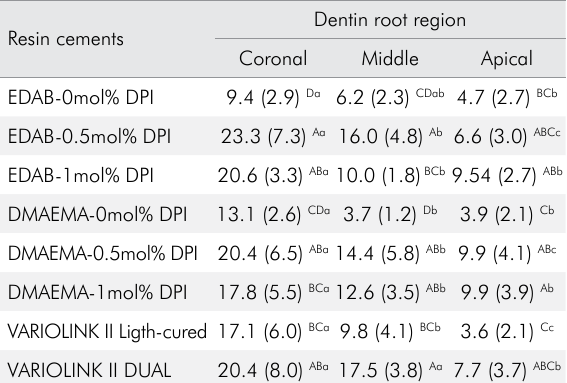
Table 1. Bond strength means (standard deviations) of experimental groups according to the different root canal regions.